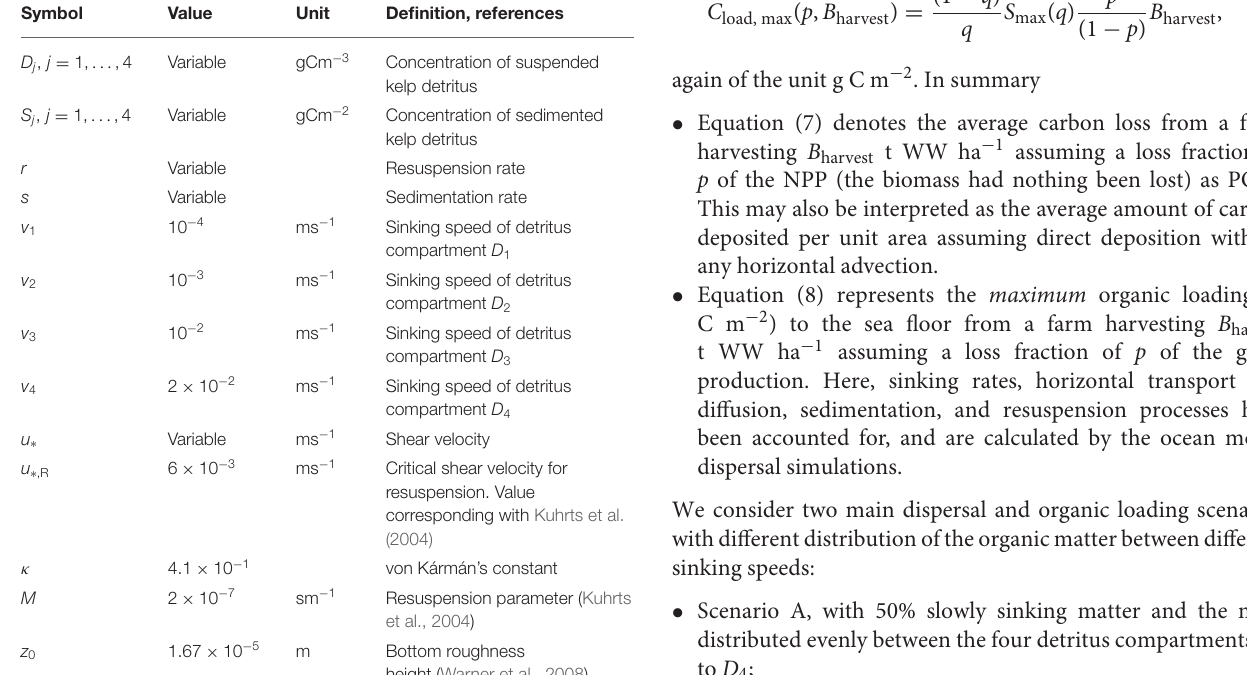
TABLE 1 | Parameters and variables used in the transport and sedimentation model. Symbol Value Unit